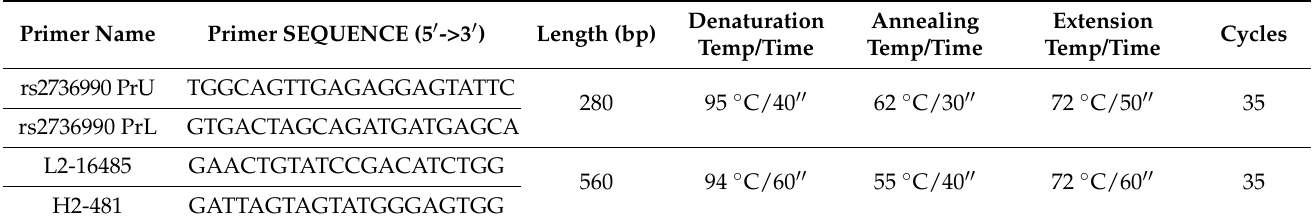
Table 4. Assessment of DNA contamination. Primer sequences, amplicon length and PCR